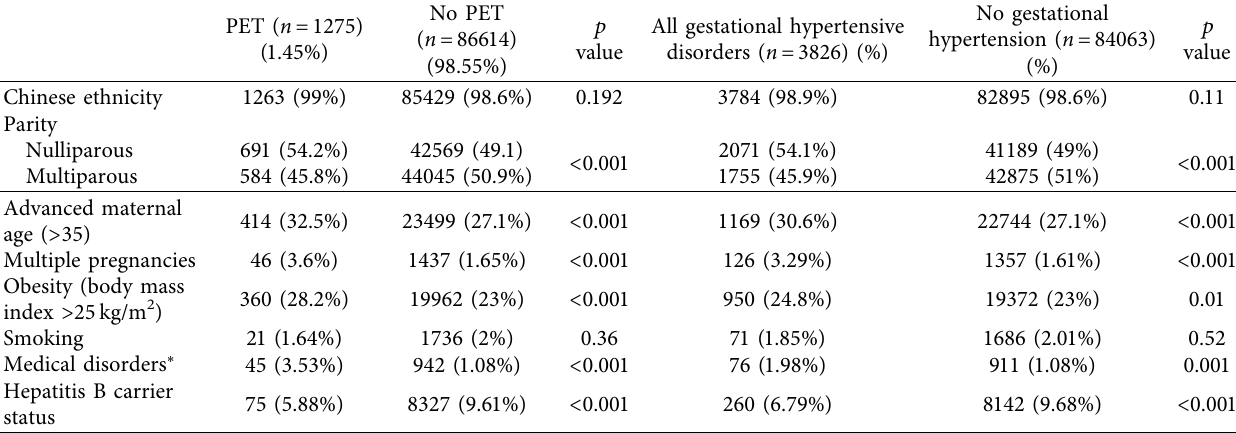
Table 4: Major risk factors for women with or without preeclampsia and all pregnancy hypertensive disorders.